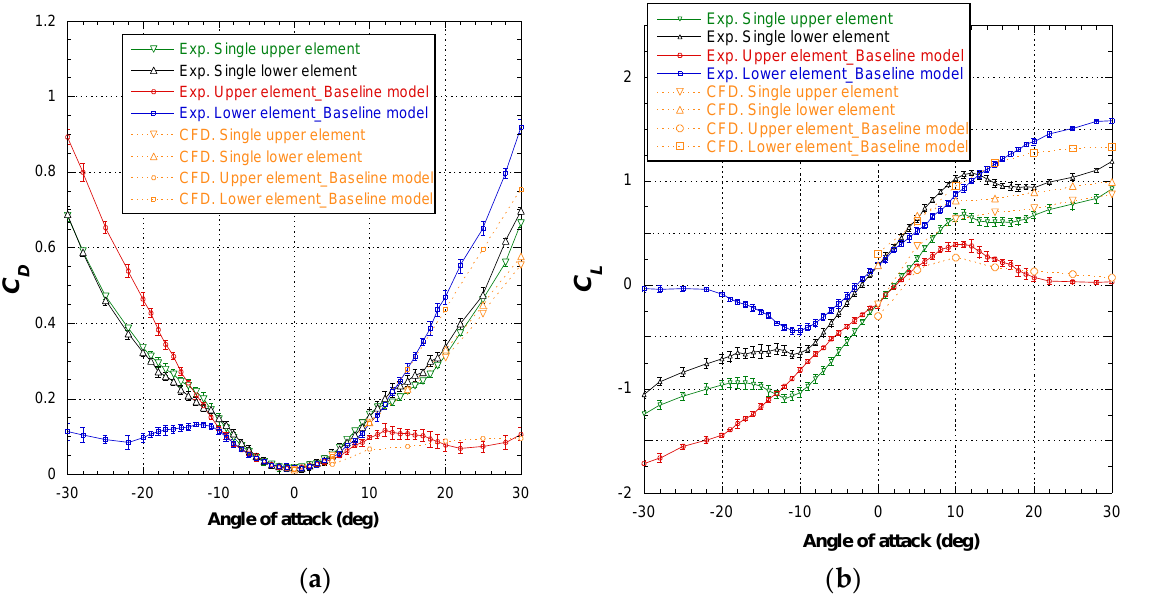
Figure 7. Comparison of aerodynamic characteristics of the wing elements as single configuration and baseline configuration: ( a ) drag coefficient; ( b ) lift coefficient.